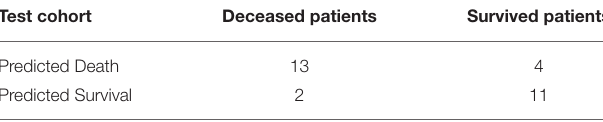
TABLE 2C | Confusion matrix of transfer learning model in the test cohort. Test cohort